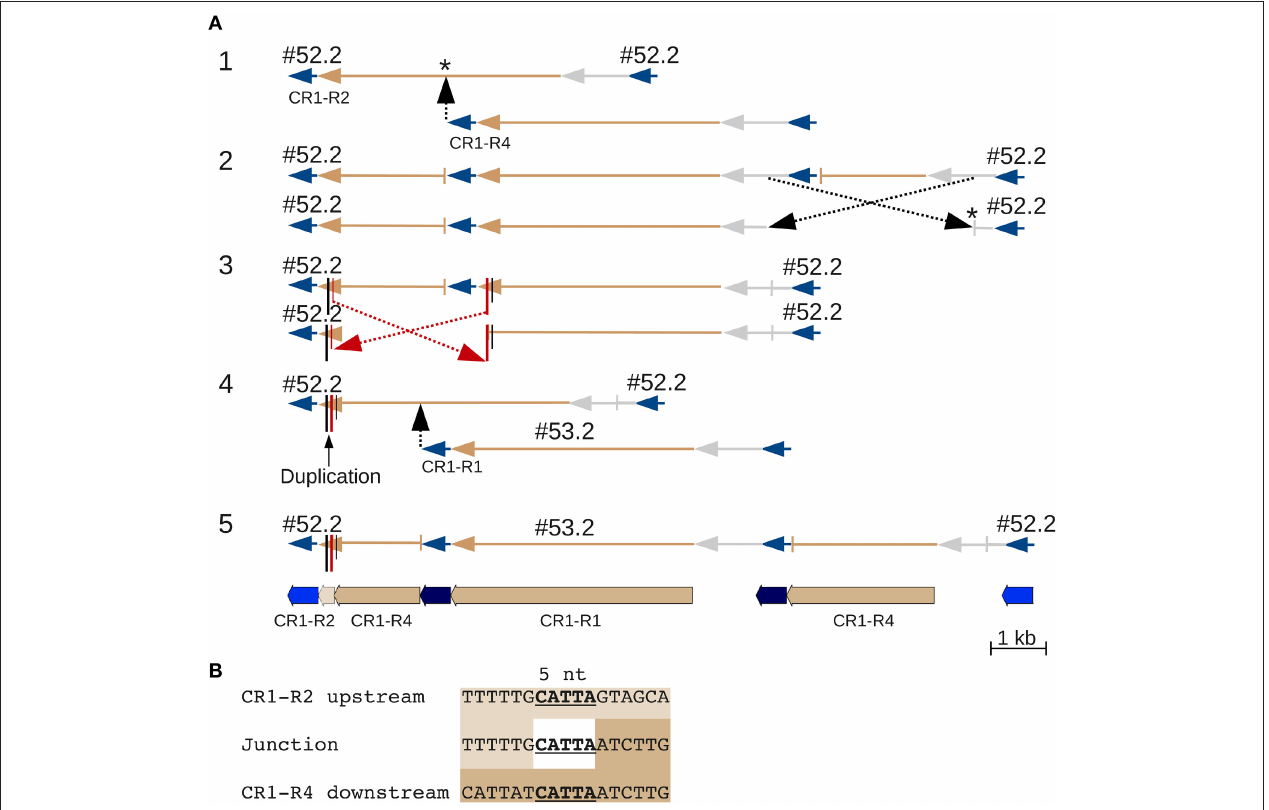
FIGURE 3 | A CR CDS duplication from nested insertion and recombination. Two CR1 elements that at first glance appear to represent a simple nested insertion, with insertion times of 326 kya and 188 kya for #52.2 and #53.2, respectively (Table S5). Closer examination reveals that element #53.2 (belonging to one of the five (R1 through R5) CR1 subgroups ( Sharma et al., 2008)) inserted into a chimeric CR1 element that contains an apparent ∼ 162 nt duplication. This chimeric element is the result of an intrastrand recombination between two different 5 nt regions of the R4 and R2 element, specifically between the downstream CR1-R4 and the upstream CR1-R2 region that adds 162 nt to the polyprotein region of this element. (A) Line drawings showing the events leading to the current sequence: original insertion of a CR1-R4 into a CR1-R2 ( * indicates that the precise insertion site is unknown) was followed by two recombinations resulting in loss of the R4 LTRs. Because the second recombination involved two offset positions (red in part 3), it appears like a duplication that can only be identified as a recombination product because the upstream, R4-derived, and the downstream, R2-derived, copy contain different alleles at the ends of their CDS. JV annotations are shown in part 5 (CR1 LTRs blue, CDS tan, UTRs not annotated). (B) Alignment showing 5 nt of identical sequence between the alternative-end joining junction and the corresponding regions in R2 and R4. Line drawings colored like JV annotations and UTRs in